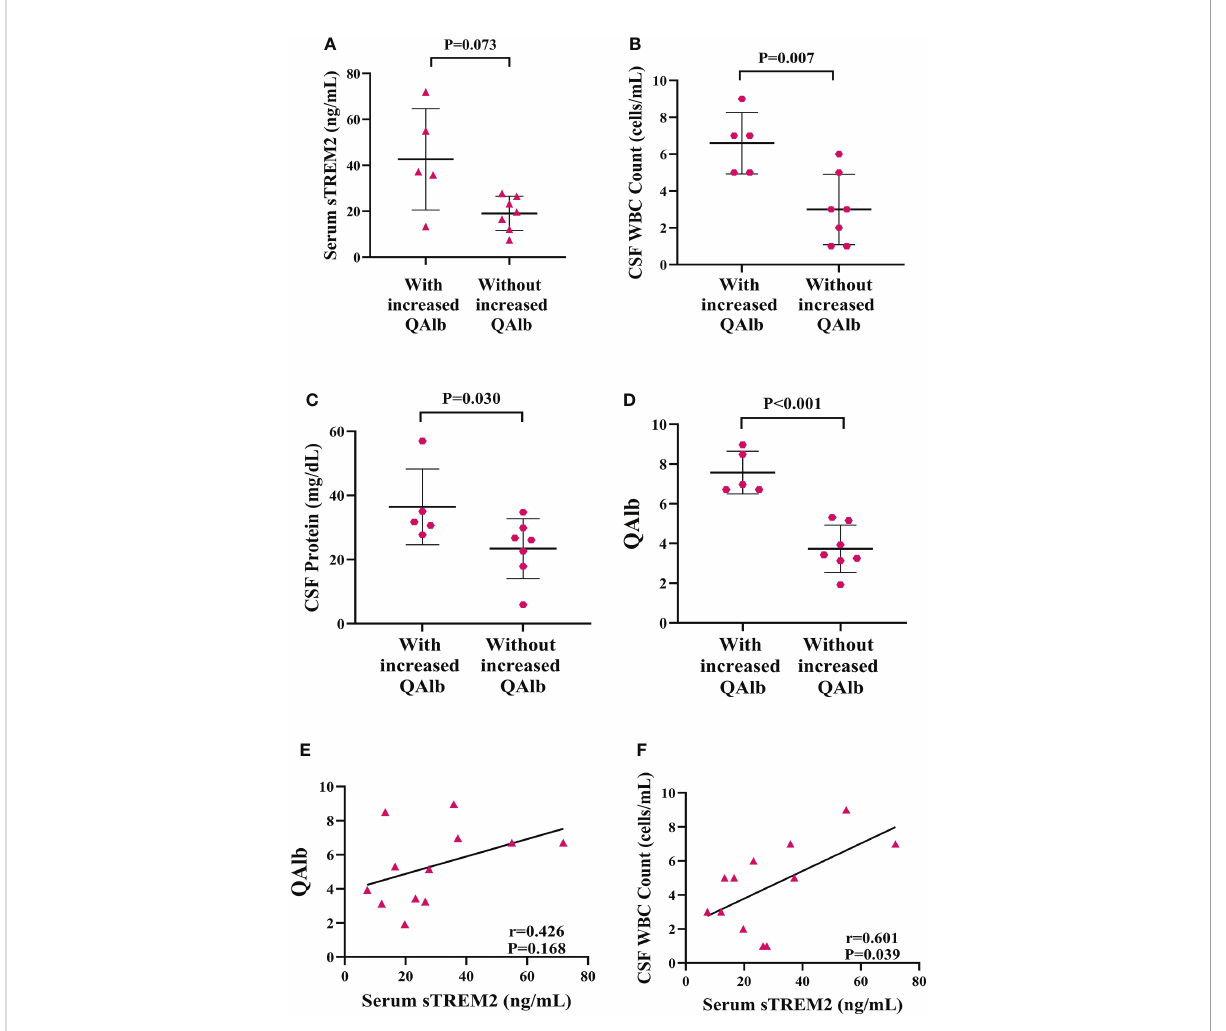
FIGURE 8 Elevated levels of biomarker of CNS in fl ammation in PACNS patients with increased QAlb. (A – D) In the PACNS patients with increased QAlb (n=5), levels of CSF WBC count, CSF total protein, and QAlb appeared to be signi fi cantly higher than in those without (n=7). (E, F) In the serum samples (n=12), there was a positive correlation between serum sTREM2 and WBC amount in CSF and a very slight trend toward signi fi cance with